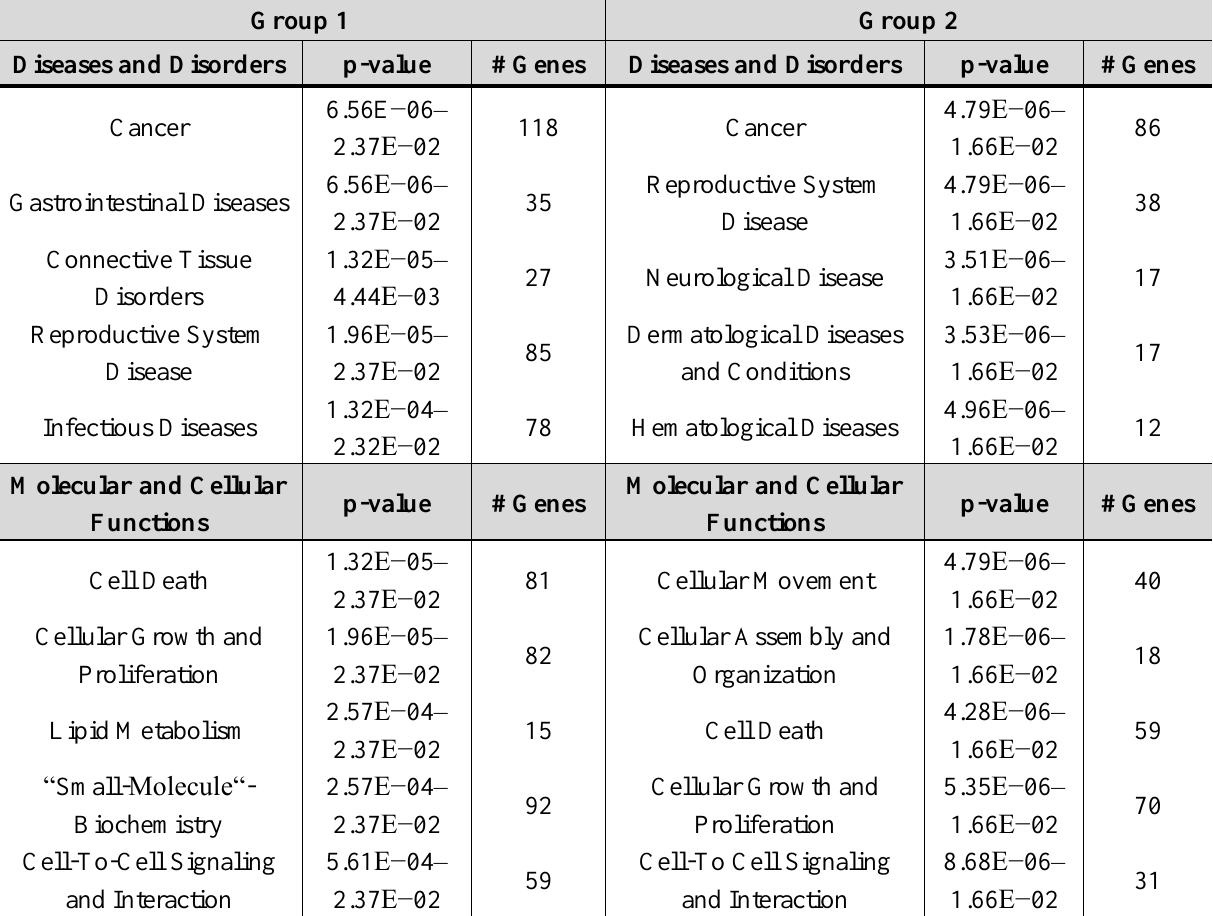
Table 1. Top bio functions. The large number of genes that are involved in most prominent diseases and disorders or molecular and cellular functions, exhibit the relevance of the regulated genes in the microarray data.